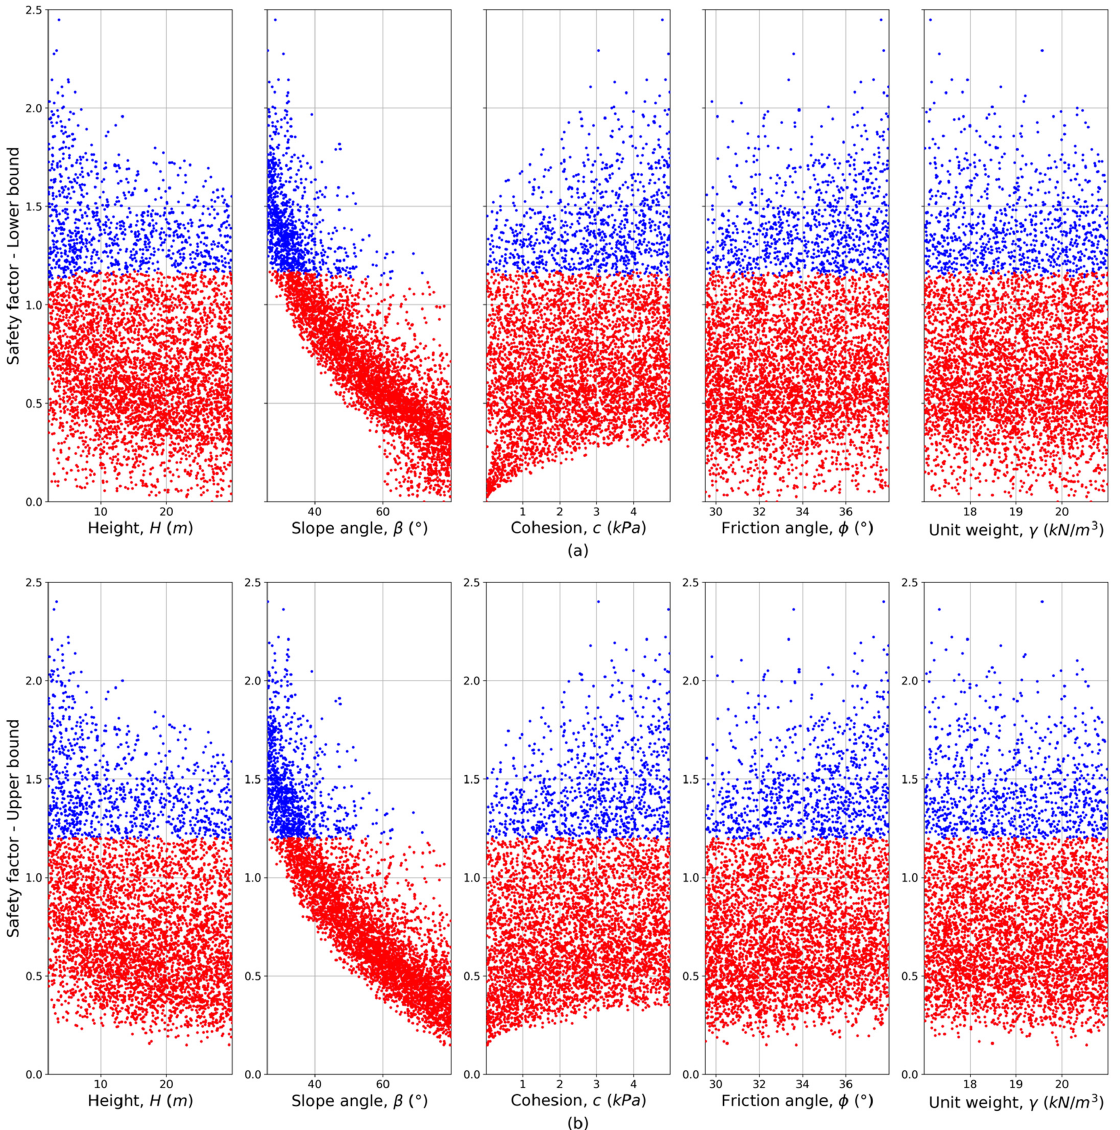
Figure 4. Scatter plots of the SF as a function of each analyzed parameter for the lower bound (SF-LB) ( a ) and upper bound (SF-UB) ( b ). Blue dots represent behavioral models (BM) and red dots non-behavioral models (N-BM).